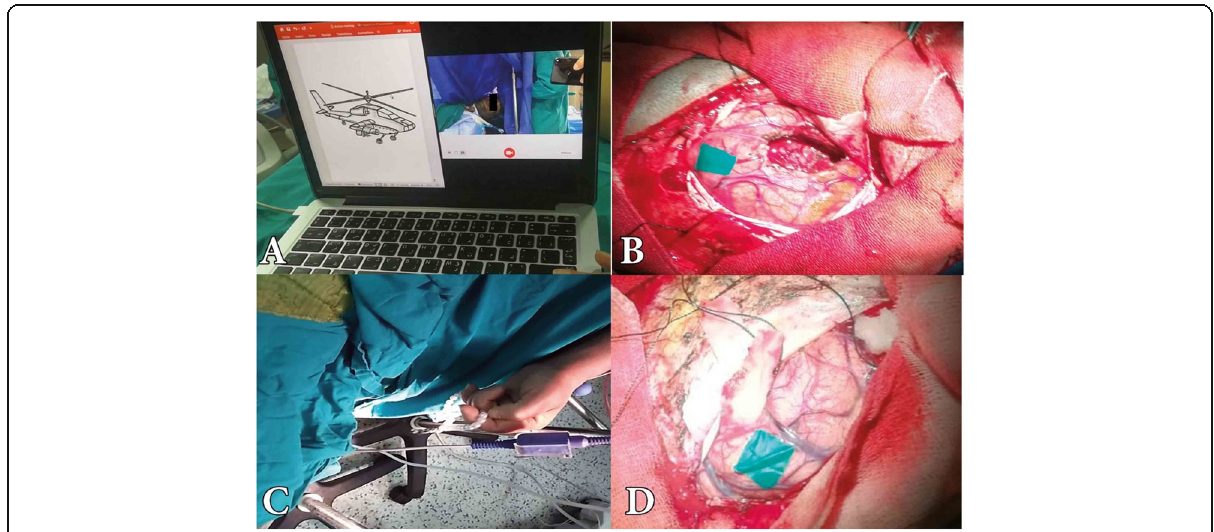
Fig. 2 Intraoperative mapping of eloquent areas. A The patient has easy visual access to computer screen projecting images and record sound for speech monitoring. B Speech area identified by a piece of colored glove and tumor resection performed more than 1 cm away from language area. C Contralateral limb exposed and patient continuously manipulate rosary for motor monitoring. D Motor area identified